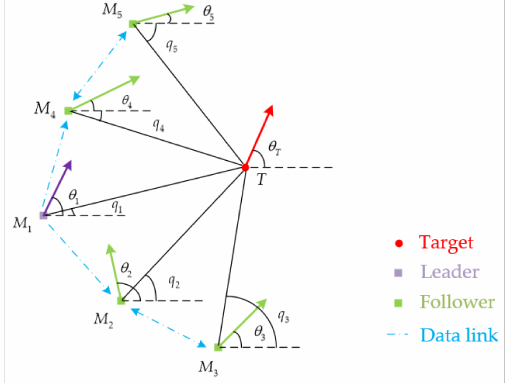
Figure 2. Encirclement salvo attack